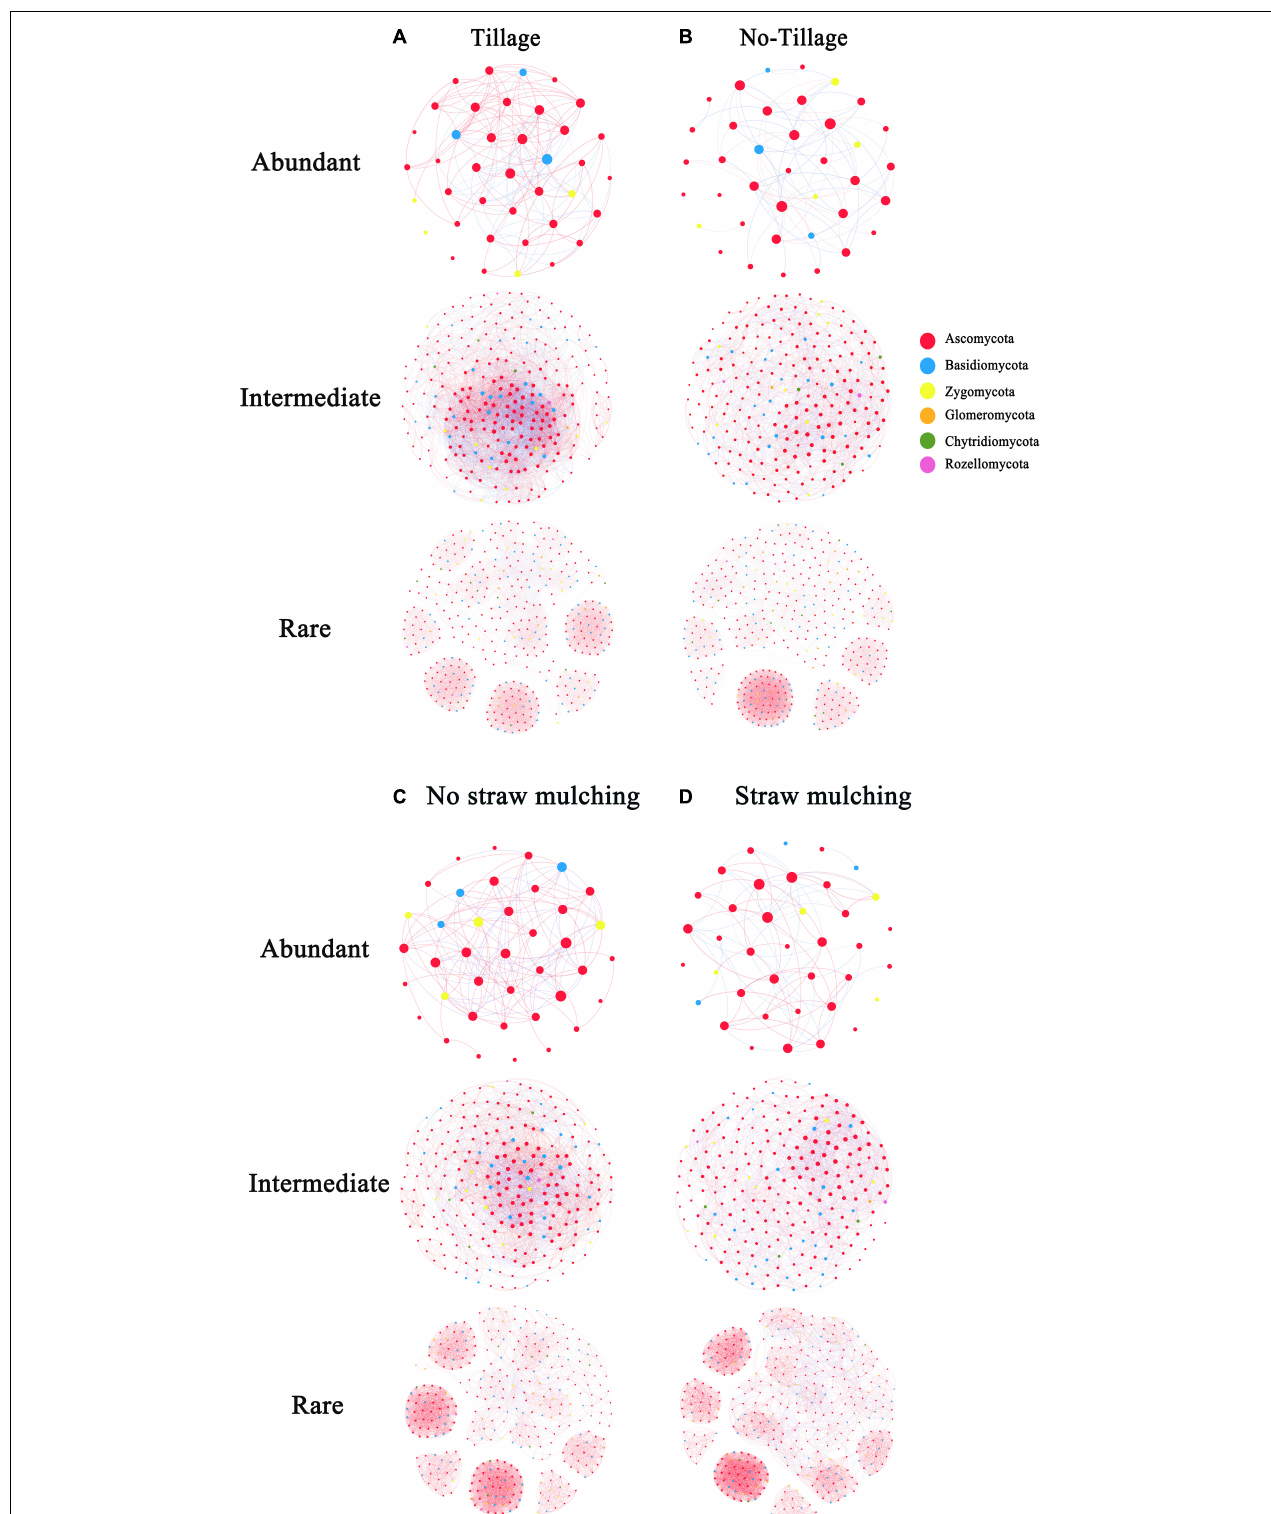
FIGURE 6 | Network co-occurrence analysis (Spearman’s ρ > 0.6 and significant p < 0.05) of fungal sub-communities in the tillage (CT and CTS) and no-tillage (NT and NTS) treatments, no-straw mulching (CT and NT) and straw mulching (CTS and NTS). The size of each node is proportional to the relative abundance; red lines and blue lines represent positive and negative correlations, respectively; nodes of the same color belongs to the same phylum. (A) Tillage (CT and CTS). (B) No-tillage (NT and NTS). (C) No straw mulching (CT and NT). (D) Straw mulching (CTS and NTS).